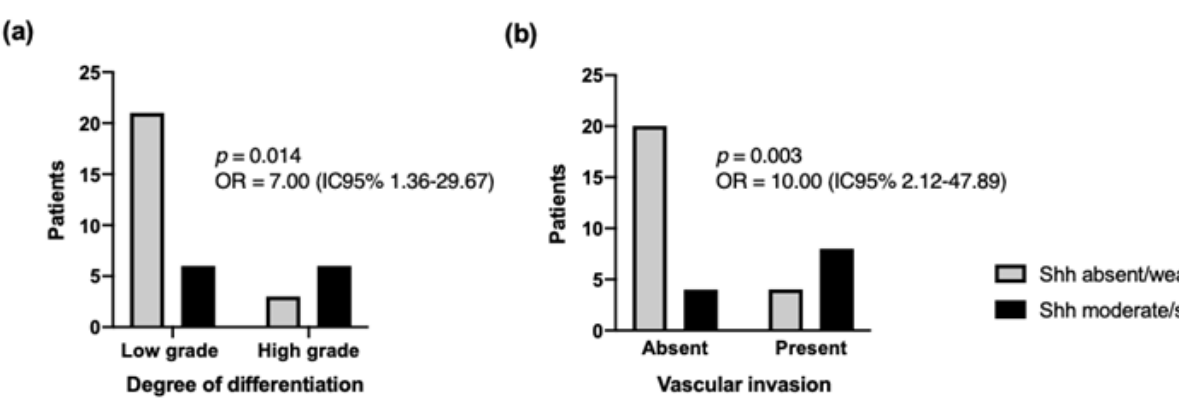
fIguRE 2 – Correlation between the Shh protein immunohistochemical score in the tumor parenchyma and (a) degree of differentiation and (b) vascular invasion in HCC from liver transplantation performed at HC-UFMG in the period between 2003-2015. Analysis by the Chi-Square Test; p-values <0.005 were considered statistically